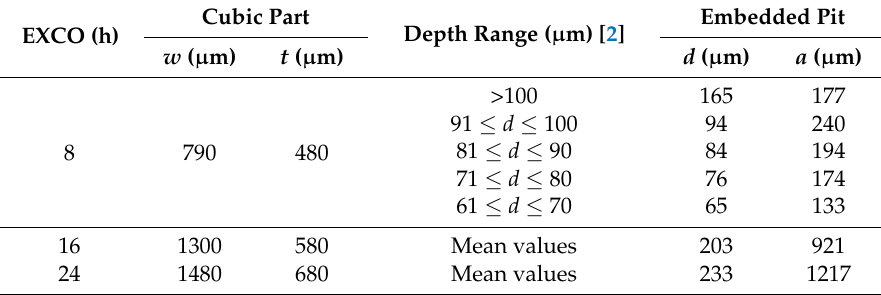
Table 3. Representative Unit Cell (RUC) dimensions (Top surface).